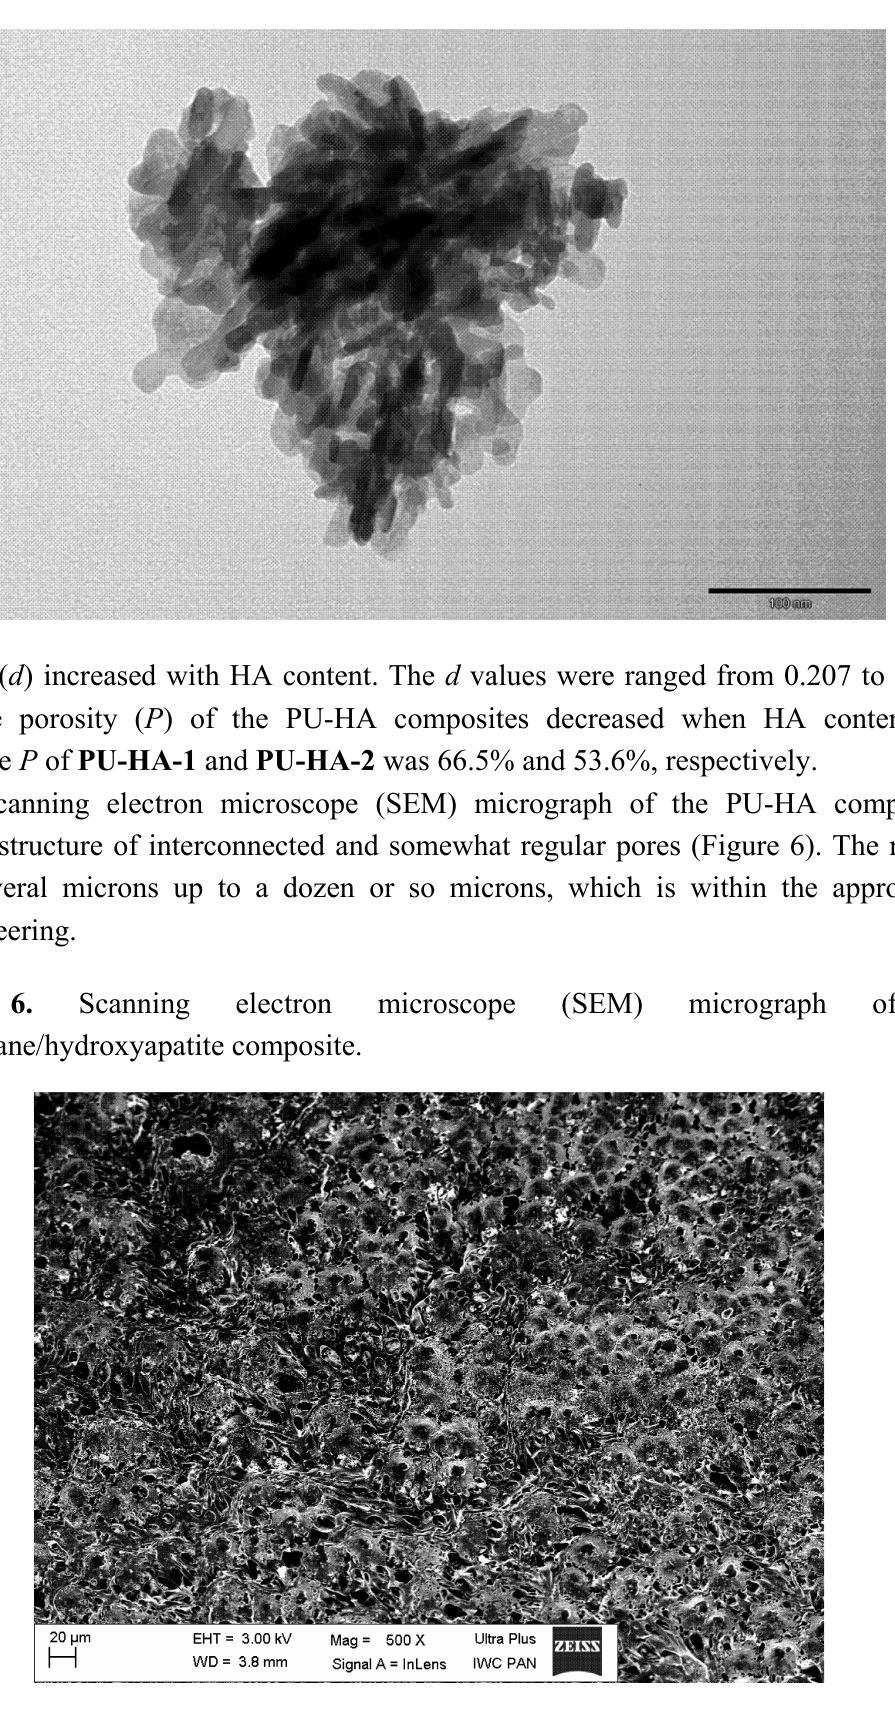
Figure 5. Transmission electron microscope (TEM) image of the hydroxyapatite used as components of the composites.